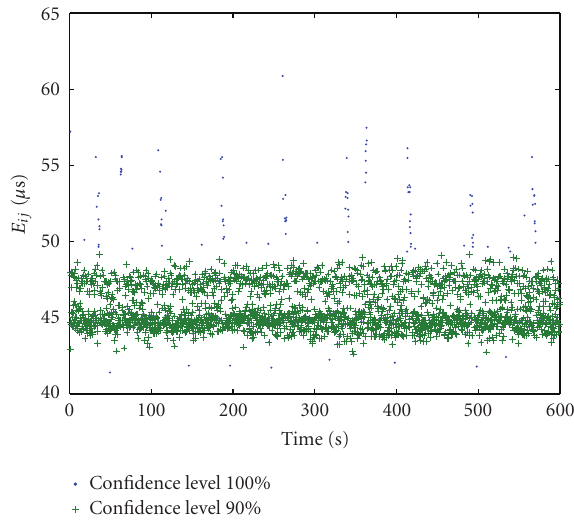
Figure 2: Error margin for each round trip time for a confidence interval of 90 and